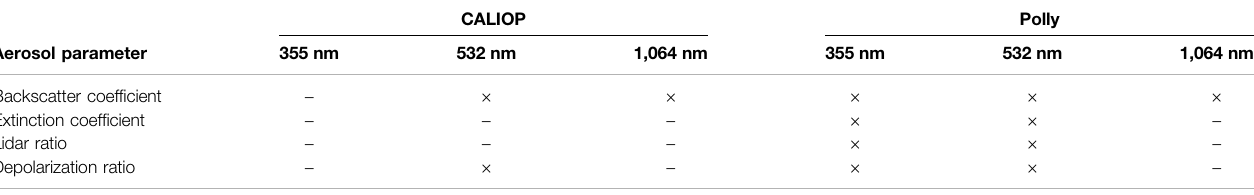
TABLE1| Particleopticalpropertiesobservablewiththespacebornedual-wavelengthCALIOP(532and1,064 nm)andtheground-basedtriple-wavelengthPolly(operated at Leipzig until end of August 2019 and aboard the icebreaker Polarastern since end of September 2019). Symbols × and − indicate available and missing retrievals. CALIOP